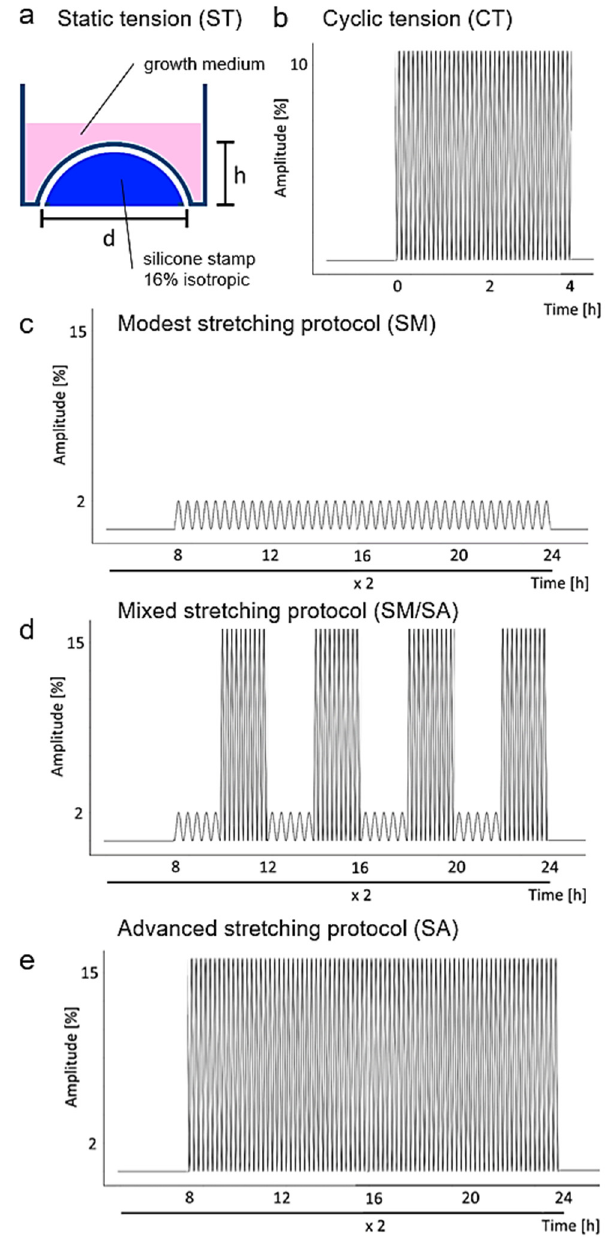
Figure 1. Schematic presentation of the investigated strain profiles. ( a ) Isotropic static tension (ST) of synovial fibroblasts with 16% tensile strain for 48 h. ( b ) Short cyclic tension (CT) with 0–10% elongation, 0.5 Hz for at least 4 h. ( c ) Modest stretching protocol (SM) consisting of 8 h without mechanical